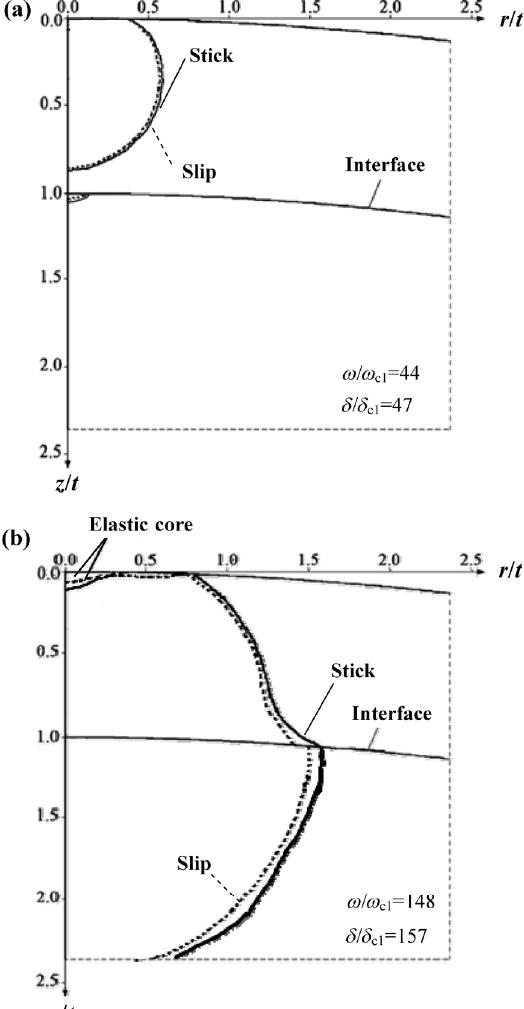
Fig. 10 Evolution of the plastic zones in the coated sphere (  = 0.32, t / R = 0.05,  y_su =  y_co = 0.001 and E co / E su = 10). (a)  /  c1 = 88 and  /  c1 = 90 and (b)  /  c1 = 156 and  /  c1 = 160.  /  = 47 for slip and stick, respectively. In Fig. c1